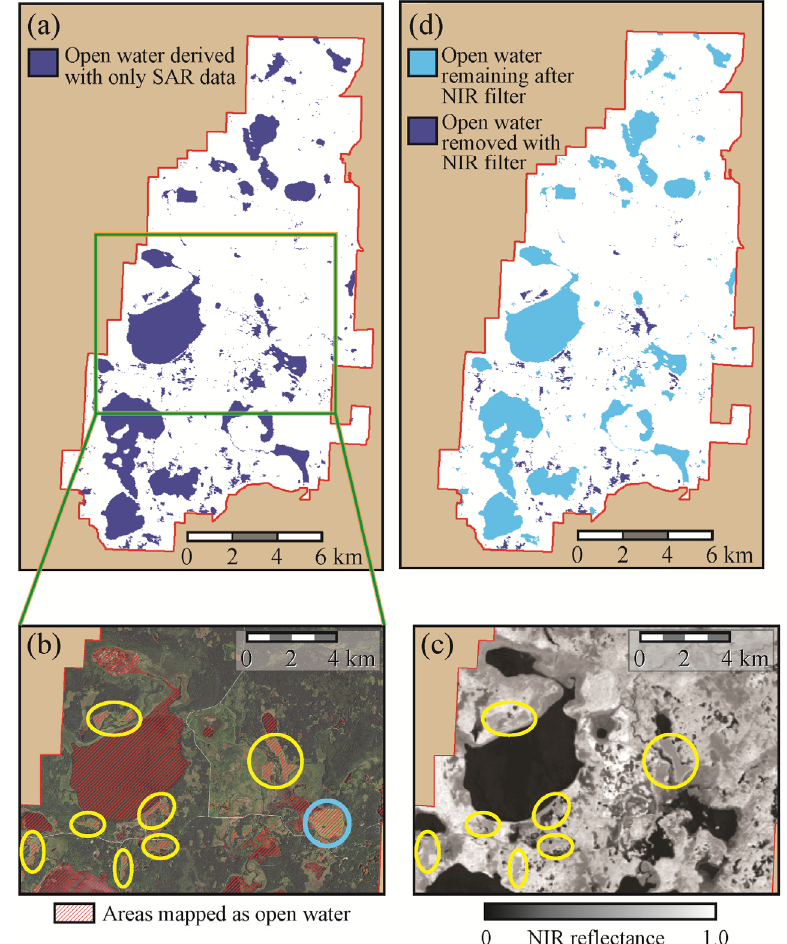
Figure 5. Errors of commission in a map of open water derived from the SAR overpass of 8 June 2011. The water map generated with the initial algorithm we applied to HV data ( a ) included areas of grassy fields (encircled in yellow in ( b )), a common outcome for nearly all dates of all years (the appearance of the area in ( b ) circled in blue, although similar to grassland, was turbid water). Landsat Thematic Mapper data for 5 June 2011 show that land-surface reflectance in the near-infrared (NIR) band was higher in the grassy areas than in areas of water/wetlands ( c ), enabling us to address this type of commission error with simple thresholding of the Landsat data ( d